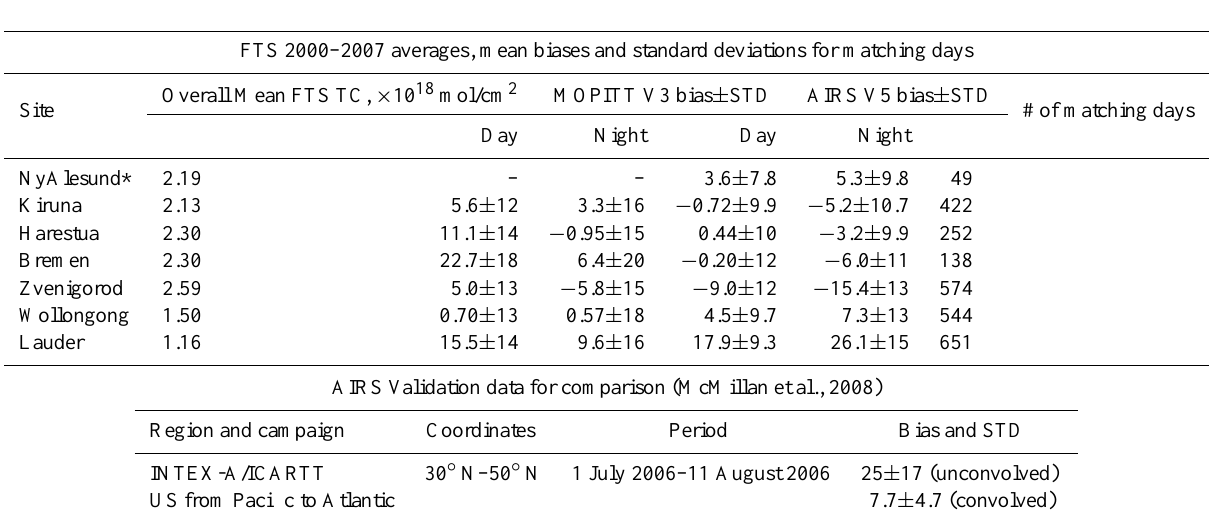
Table 3. Compilation of validation data and comparison with available campaigns.